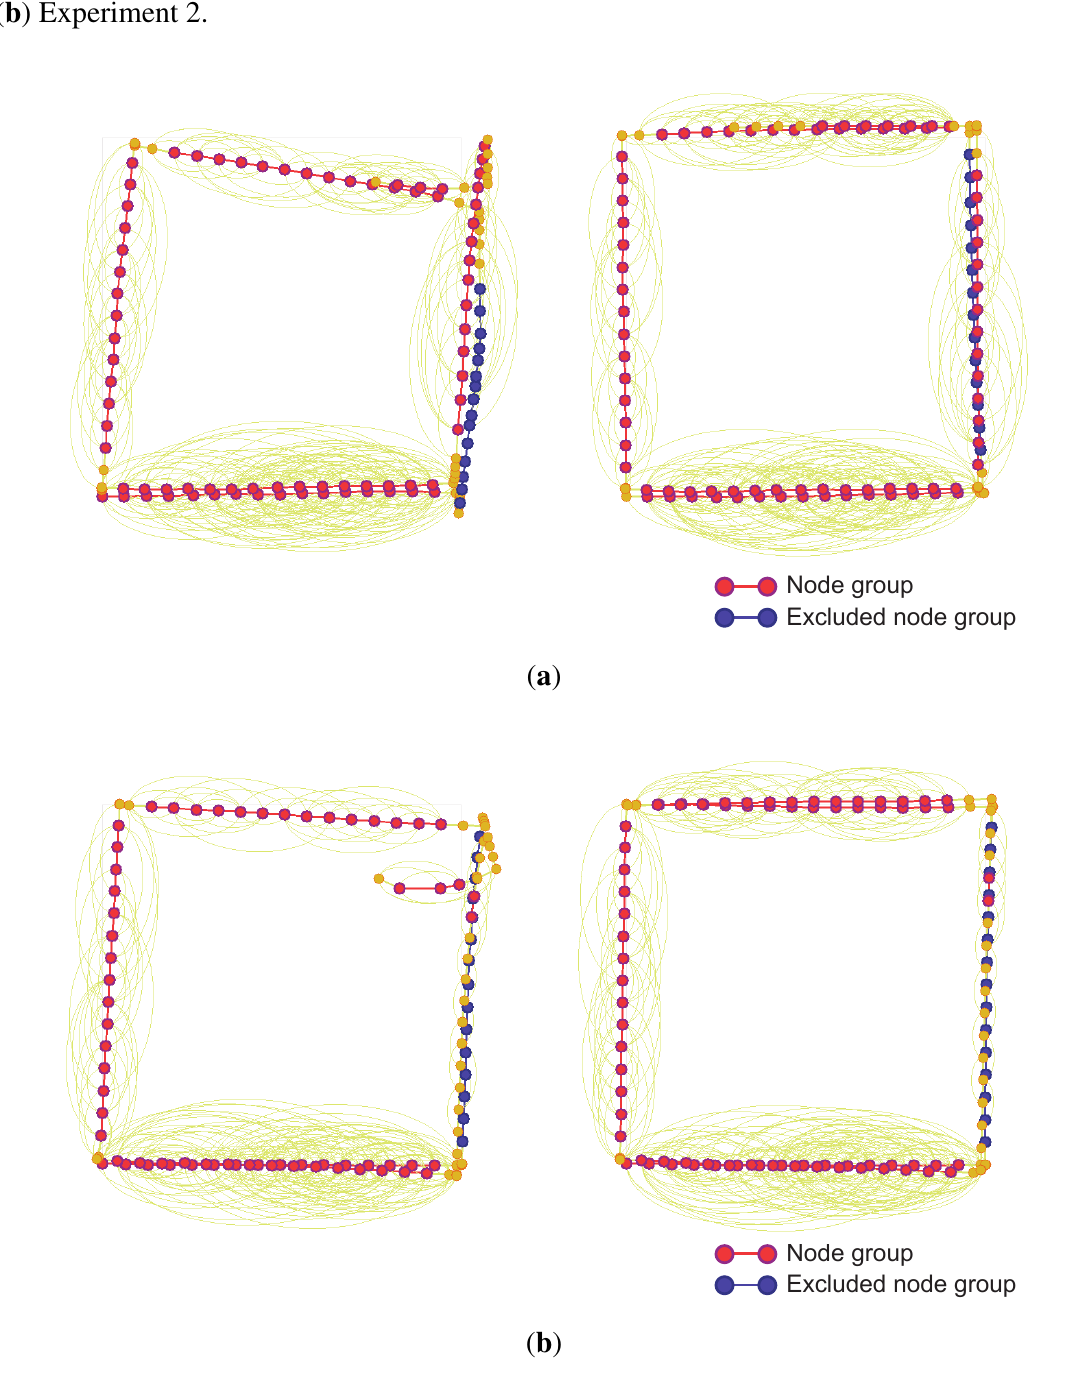
Figure 20. Left: At the moment of movement detection in low dynamic environments. Right: Reoptimized graph structures after excluding false constraints. ( a ) Experiment 1; ( b ) Experiment